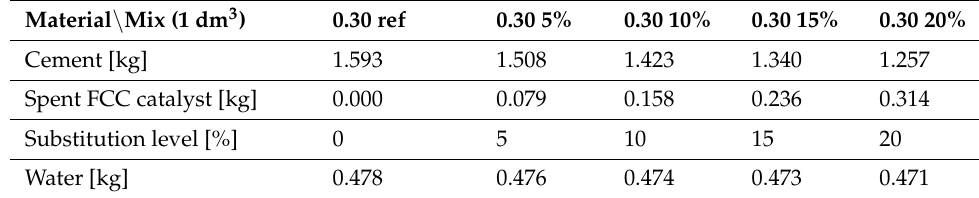
Table 2. Formulations of 1 dm 3 of cement paste